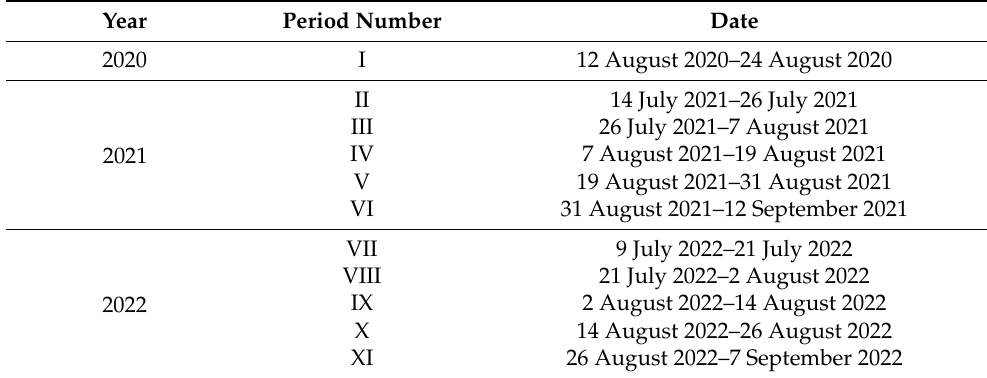
Table 1. Eleven deformation-monitoring periods and their corresponding dates.